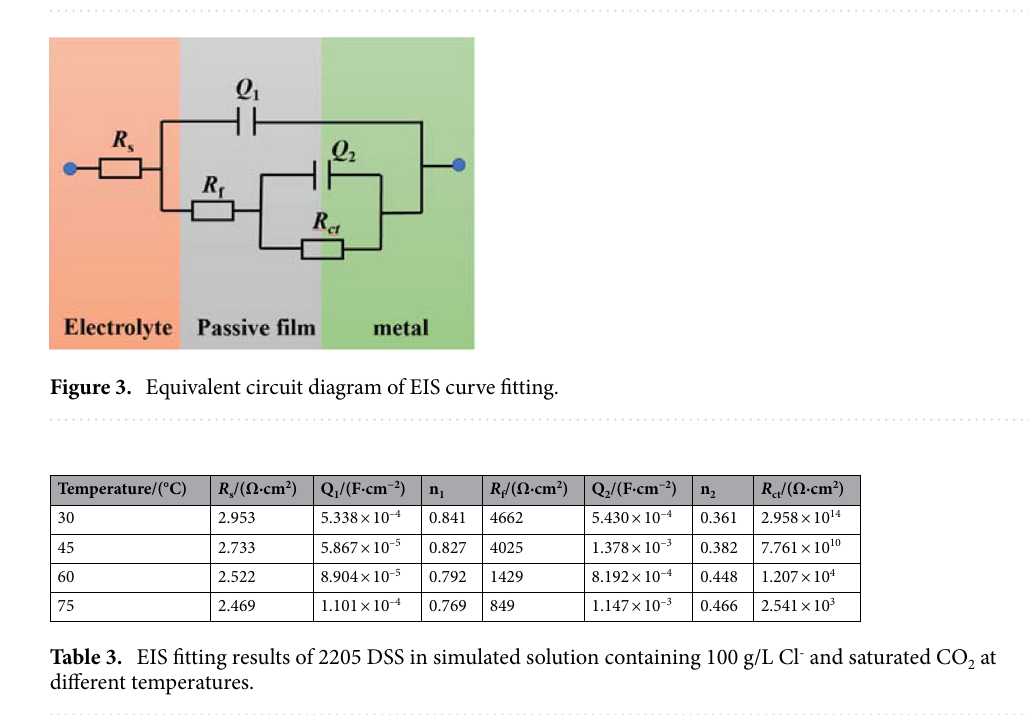
Figure 2. EIS curves of 2205 DSS at different temperatures ( a ) Nyquist plot, ( b ) Bode plot.